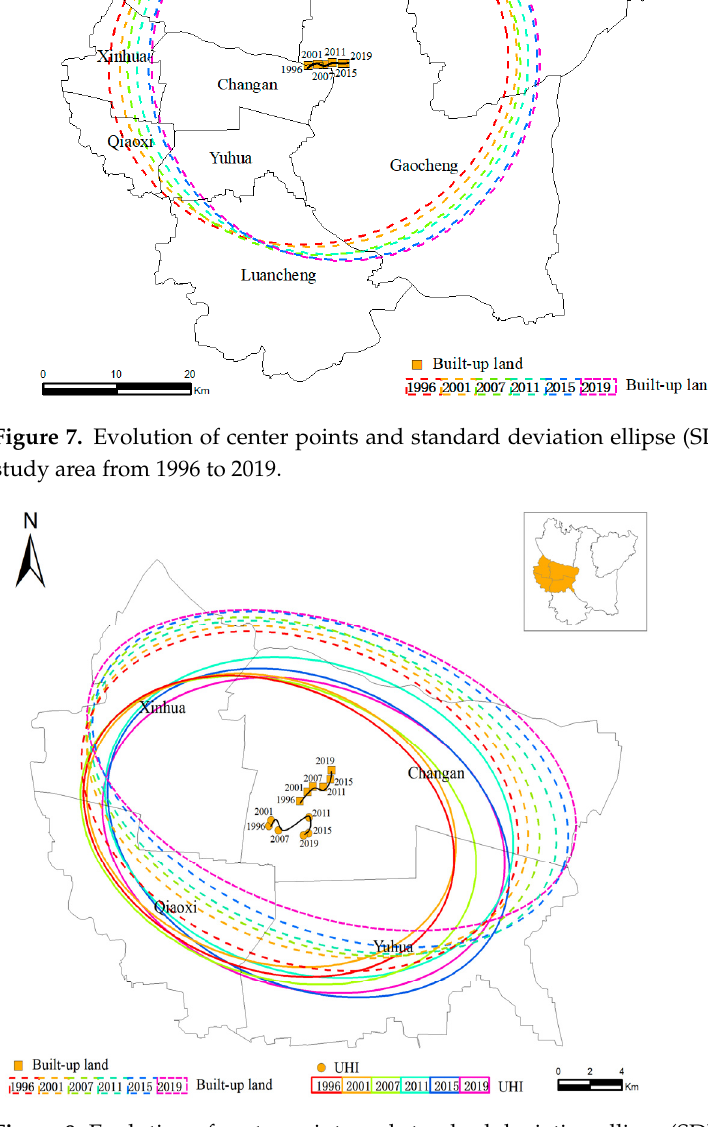
Figure 8. Evolution of center points and standard deviation ellipse (SDE) of the built-up land and urban heat island (UHI) of the downtown from 1996 to